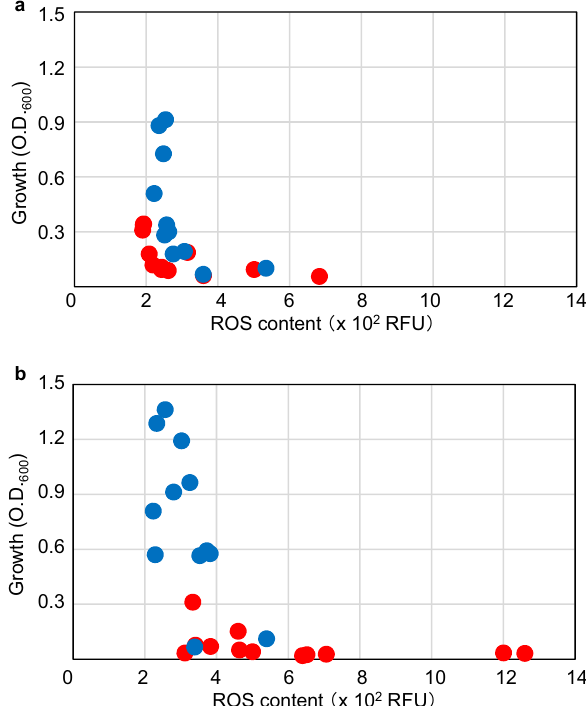
Figure 6. Analysis of growth and ROS levels in ΔrecA306 polA25 cells. ( a ) Sensitivity of ΔrecA306 polA25 cells to M9GCAA medium. For TK1230 and TK1224 cell samples grown in M9GCAA medium, two-dimensional scatter plots were constructed with the mean ROS levels and absorbance on the x and y axes, respectively. TK1230 and TK1224 are indicated using red and blue, respectively. ( b ) Sensitivity of ΔrecA306 polA25 cells to L medium. For TK1230 and TK1224 cell samples grown in L medium, two-dimensional scatter plots were constructed as described in ( a